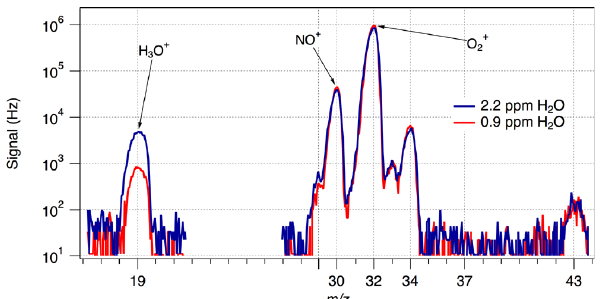
Fig. 5. Observed mass spectra with 0.9 (red) and 2.2 (blue)ppm H 2 O in the sample flow. The complete declustering of ions entering the mass spectrometer is demonstrated by the absence of a peak corresponding to H 3 O + · H 2 O at m/z